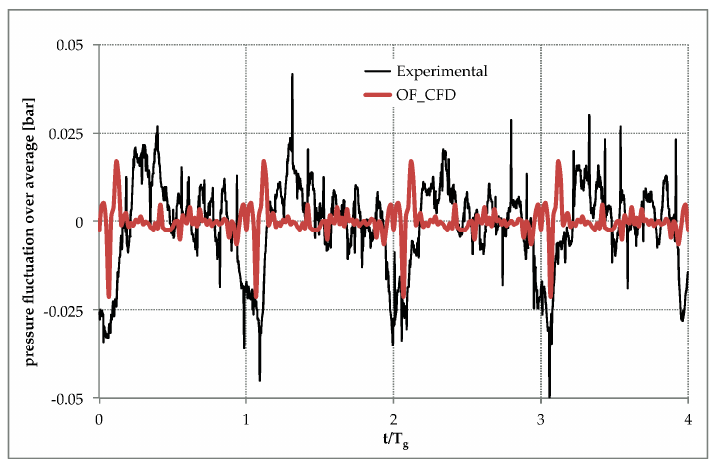
Figure 18. Experimental and computational flow ripple time series at outlet pressure port for 1000 rpm and 1 bar of working pressure. Pressure data are fluctuations over average pressure (1 bar). Time has been normalized with gearing period T g = 1/( Z −